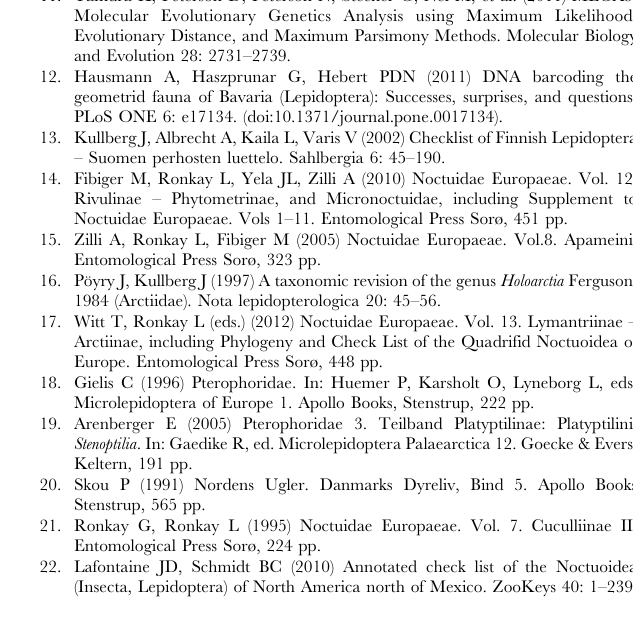
Table S2 Provisional check-list of arctic-alpine and boreo- montane species shared between the Alps and Fennoscandia but not barcoded from both major distribution areas in this study; taxonomic status of several taxa needs revision. Table S3 Minimum, mean and maximum intraspecific variation in DNA barcodes in study species within and between the study regions. NA refers to North America, AL to Alps and FE to Fennoscandia. Species showing over 2% intraspecific divergence within or between the regions in question are shown highlighted. Table S4 Minimum, mean and maximum variation in DNA barcodes between allopatric species, which morphologically are considered distinct taxa, but which genetically are closely similar. NA refers to North America, AL to Alps and FE to Fennoscandia. Superscript numbers after the species refer to the areas of occurrence as follows: 1= Alps, 2 = Fennoscandia, 3= North